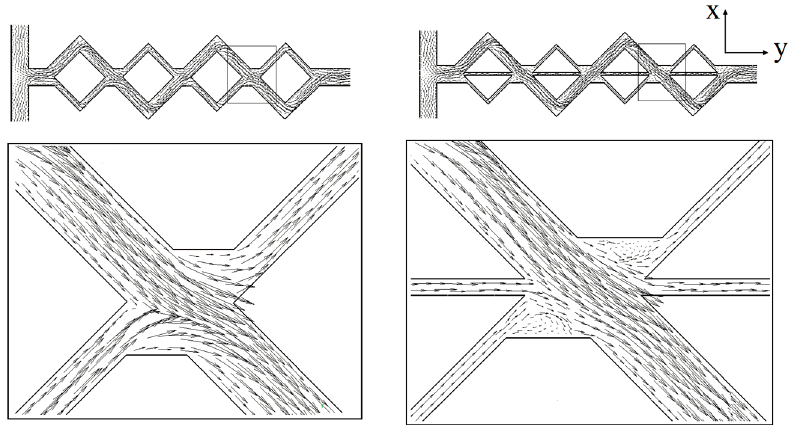
Figure 4. Velocity vector plots on x - y plane at Re = 40 in unbalanced two-split and three-split rhombic